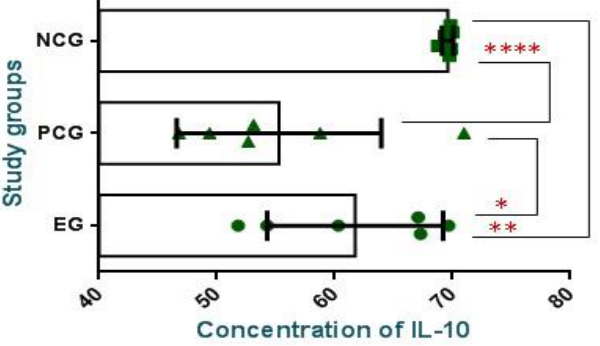
Figure 2. Total results of IL-10 among the experimental groups and the time points (*), (**), and (****) referred to significant differences between groups as P≤0.05, P≤0.01 and P<0.0001 respectively.